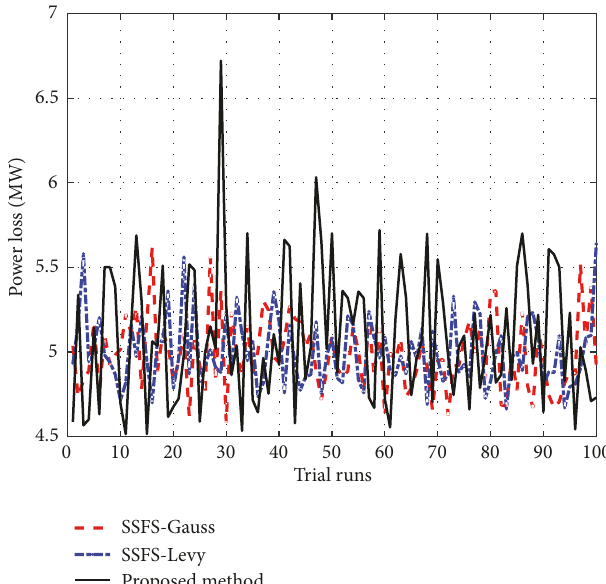
Figure 4: Comparisons of 100 runs for power loss objective of IEEE 30-bus system obtained by three methods.